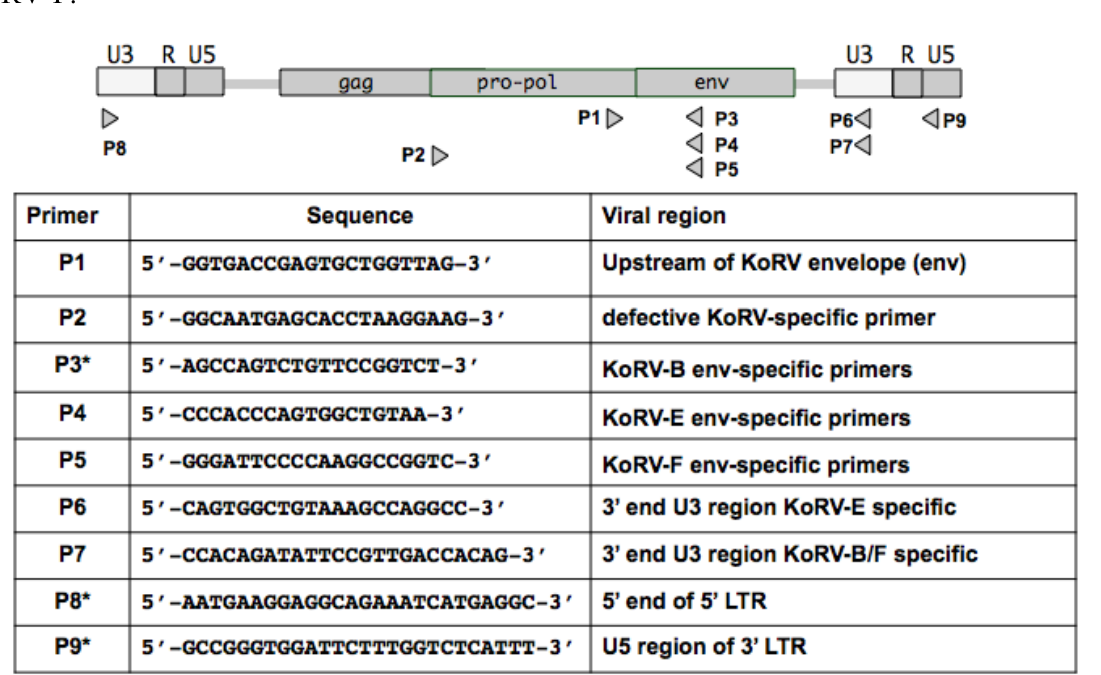
Figure 1. Schematic representation of the KoRV proviral genome showing positions of primer pairs used to clone KoRV envelope variants and defective KoRV envelopes. Diagram not to scale. *Primers used in previous studies